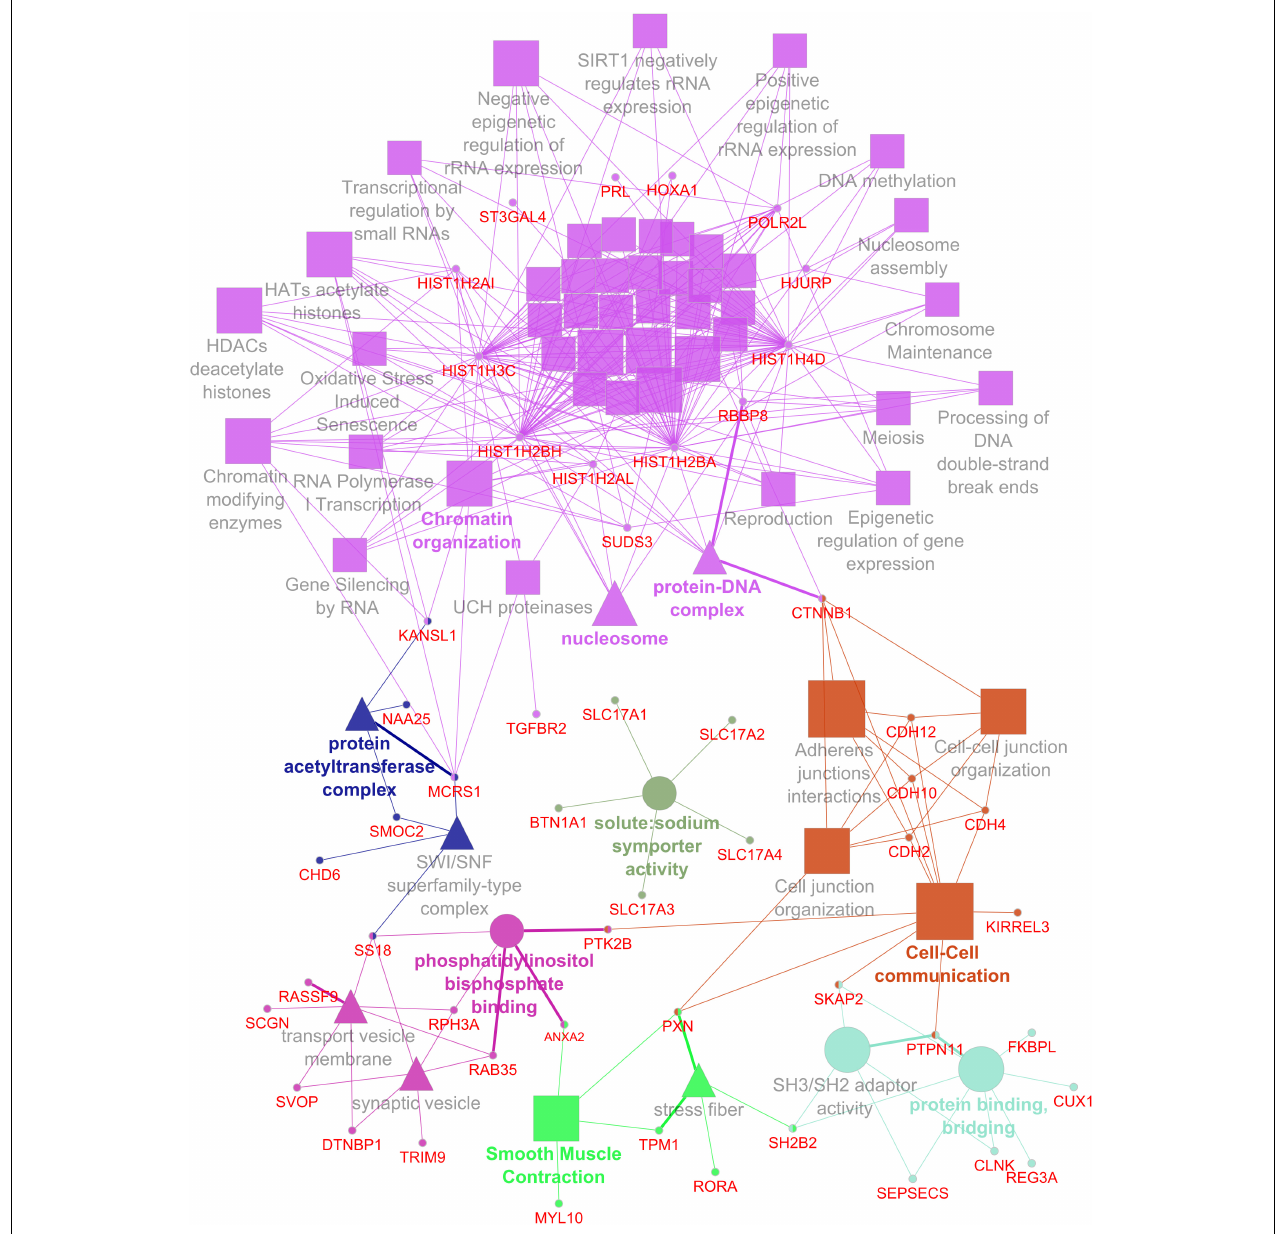
FIGURE 2 | Network representing enriched GO terms and linked genes based on QTL for hematological traits related to the calcium and phosphorus homeostasis.